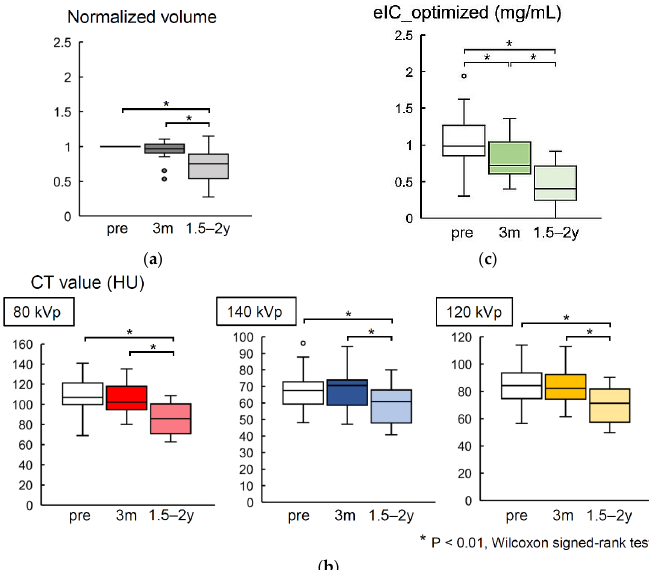
Figure 5. The changes in indices during charged-particle radiation therapy. In comparison with the pre-treatment values, the ( a ) tumor volume and ( b ) computed tomography values (80, 140, 120 kVp) significantly reduced at 1.5–2 years post-treatment, but none of these parameters showed significant changes at 3 months after treatment. ( c ) On the other hand, the eIC_optimized showed significant reductions at both 3 months post-treatment and 1.5–2 years post-treatment.